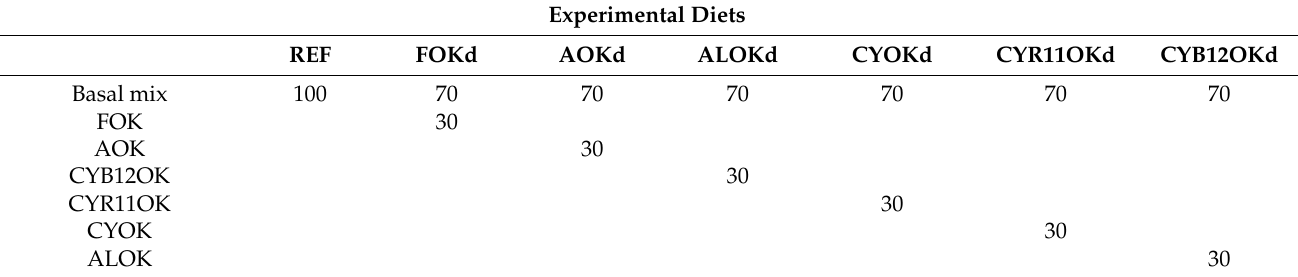
Table 3. Formulation (%) and proximate composition (% Dry matter, DM or kJ g − 1 DM) of the basal mixture and experimental diets for the digestibility